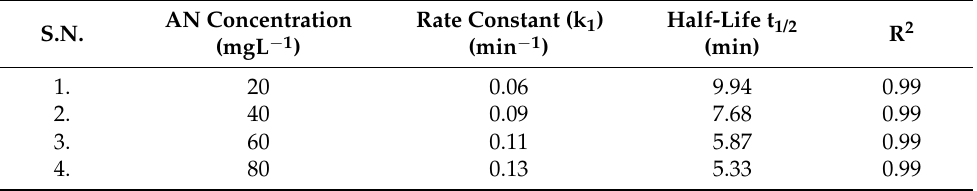
Table 4. Kinetic parameters and their values for pseudo first order kinetic model proposed by Langmuir–Hinshelwood for degradation of AN by synthesized